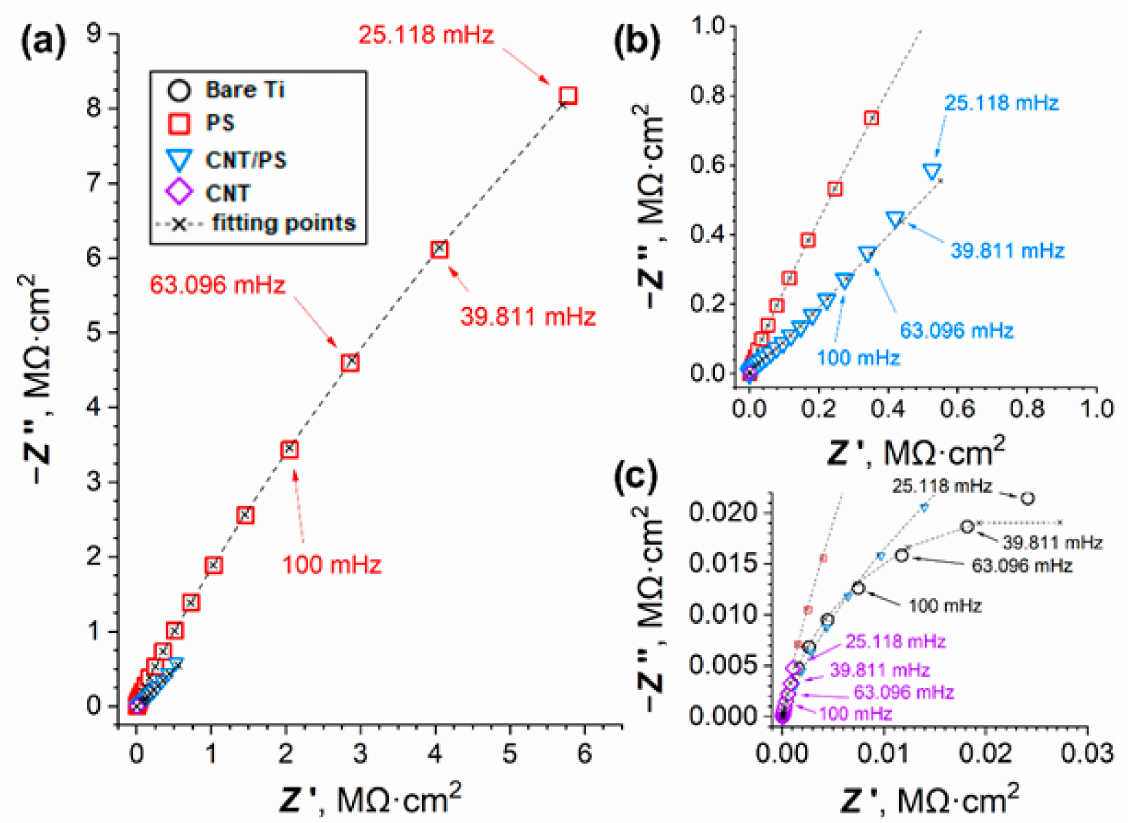
Figure 5. EIS spectra of the titanium samples coated with PS, CNT and co-deposited CNT/PS recorded in Ringer’s solution after 2 h of immersion presented as Nyquist plots at different scales ( a – c ) to show the observed capacitive